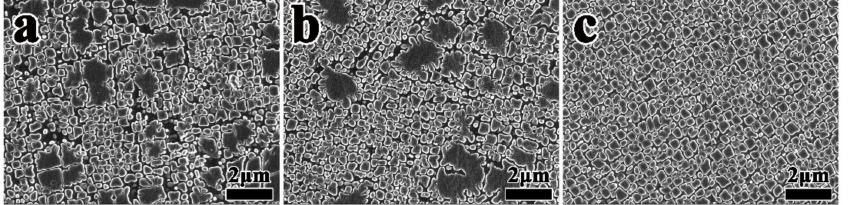
Figure 9. The γ ’ phase under isothermal heat treatment at different temperatures with the soaking time of 2 h: ( a ) 1150 ◦ C; ( b ) 1160 ◦ C; ( c ) 1175 ◦ C.